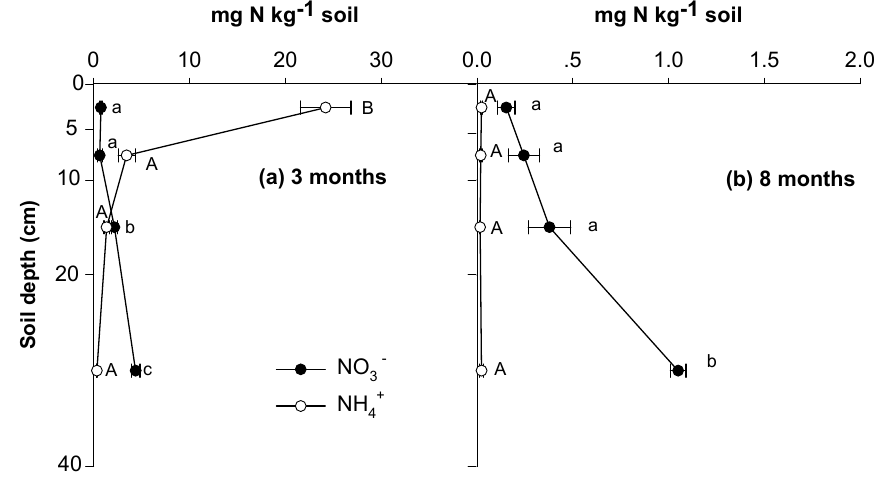
Figure2. ( a ) Concentrations of soil exogenous NO 3 − and NH 4+ (mean ± standard error (se); n = 8) three months after N addition. ( b ) Concentrations of soil exogenous NO 3 − and NH 4+ (mean ± se; n = 5) eight months after N addition. Note: Differences of NO 3 − among soil layers are indicated by different lowercase letters. Differences of NH 4+ among soil layers are indicated by different uppercase letters. Data are graphed at the mid-point of our soil sampling